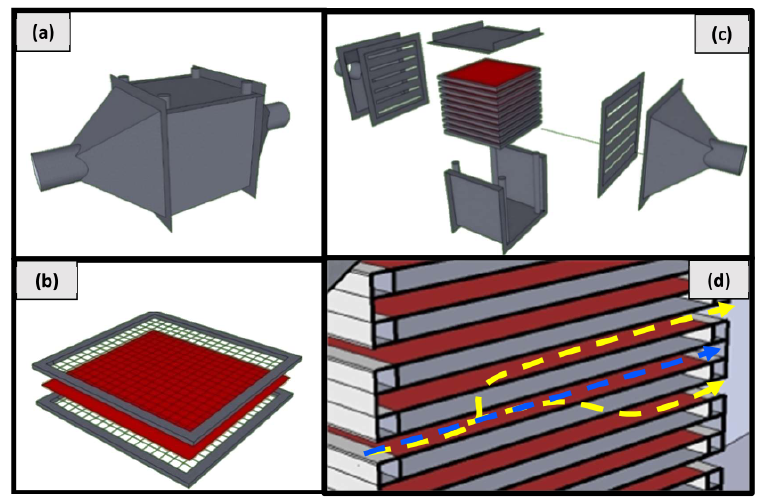
Figure 11. Scheme of the metallic support for soot particle collection in the test bench. ( a ) Metallic cartridge, ( b ) ceramic paper ( ) between metal meshes ( ), ( c ) exploded view and ( d ) alternately plugged channels and exhaust flowing.